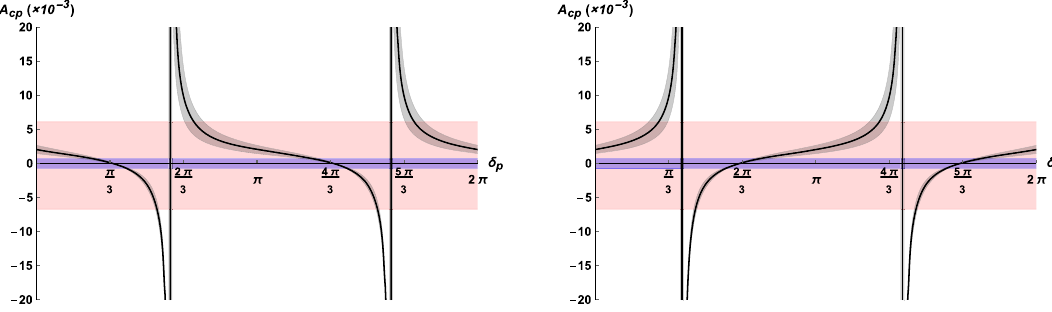
Fig. 1 Ratio of penguin and tree amplitudes P /( T + C ) dependent on the strong phase δ p in the cases of negative (left) and positive (right) strong phase δ I . The gray bands represent the uncertainties, and the blue solid and dashed lines are P /( T + C ) = 2 and − 2 respectively